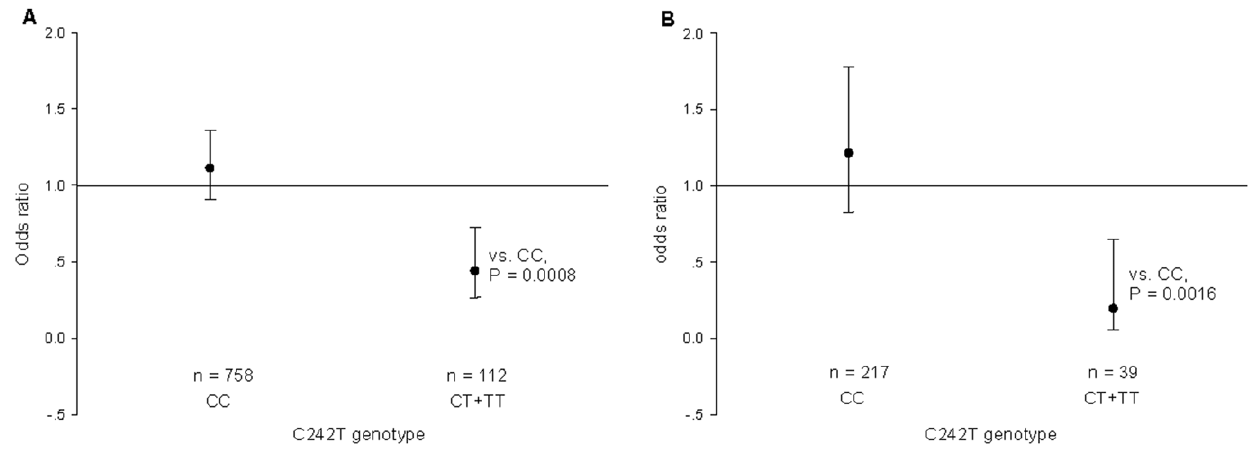
Figure 1. Difference of prevalence of metabolic syndrome between C242T genotypes in all participants and smokers. The odds of prevalence of metabolic syndrome in genotypic group is expressed relative to the overall risk of all participants (A) or smokers (B), and adjusted for age, sex, body height, body weight, antihypertensive medication, antidiabetic medication, current smoking, alcohol intake and heart rate. Vertical lines denote 95% confidence intervals. For each genotype, the number of participants is given. doi:10.1371/journal.pone.0031926.g001 PLoS ONE |